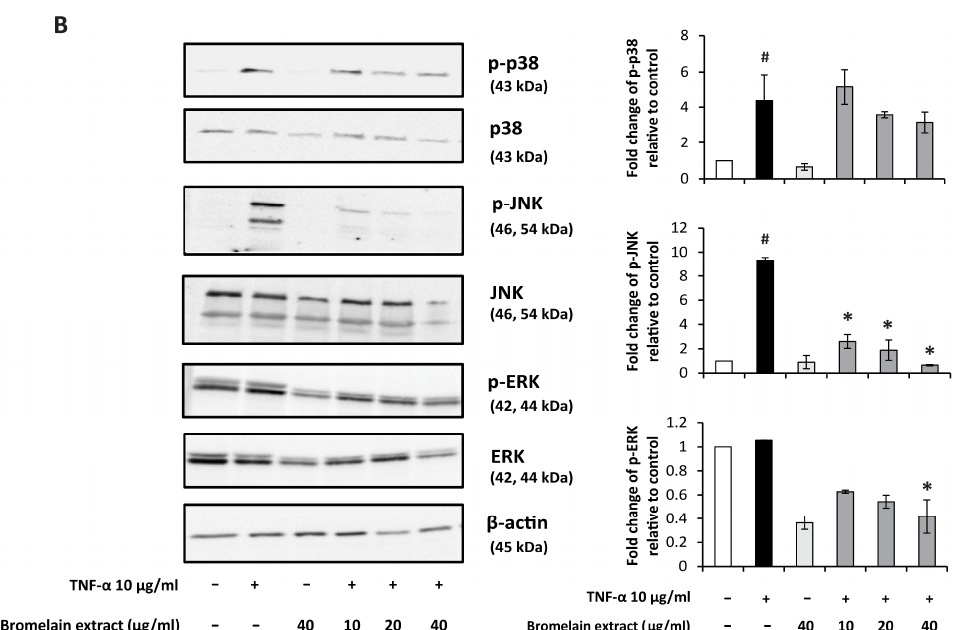
Figure 4. Effect of bromelain extract on the NF- κ B and MAPK pathway. The inhibitory effects of bromelain extract 1 h before treatment with 10 ng/mL human recombinant TNF- α for 10 min. The cell lysate was collected and subjected to Western blot analysis( A ). The density of each band was analyzed using TotalLab TL120 software ( B ). Each value is expressed as the mean ± SD. # p < 0.05 compared with control, * p < 0.05 compared with TNF- α treatment